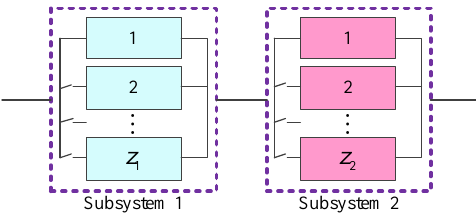
Figure 8. A series system.